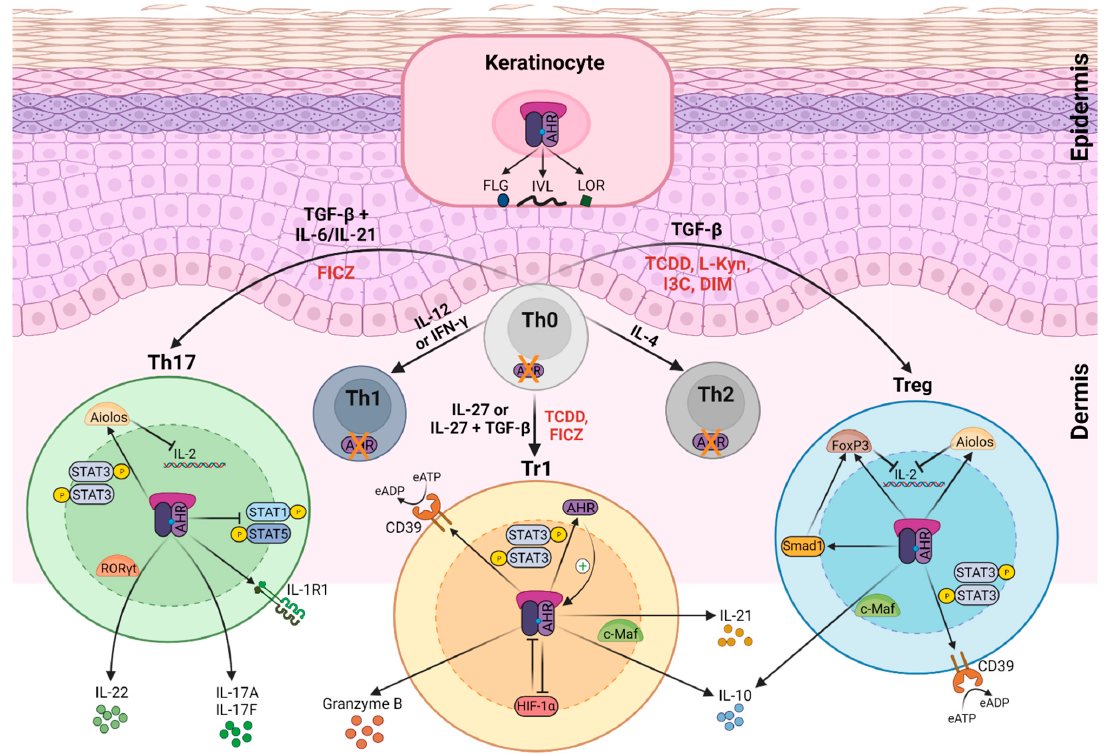
Figure 2. Effects of AHR signaling in keratinocytes and different T cell subsets. AHR expression depends on T helper (Th) cell subsets. In naïve CD4+ T cells (Th0), Th1 cells, and Th2 cells, AHR expression is negligible. Th17 express the